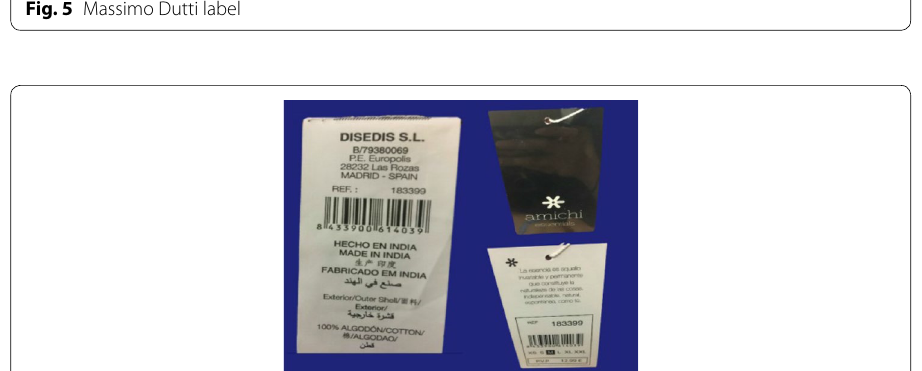
Fig. 5 Massimo Dutti label